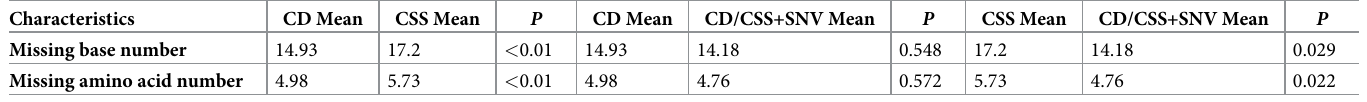
Table 4. The number of missing bases and amino acids of three groups.